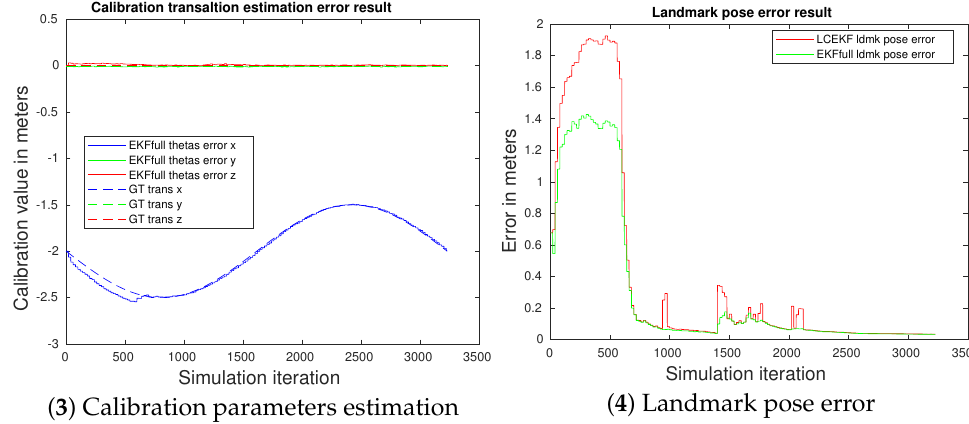
Figure 15. SLAM without the IMU and smooth sinusoidal noise. With a good random walk for K parameters, the estimation performed properly, making the EKFfull work fine. Note that the LCEKF and EKFfull performed in the same way.